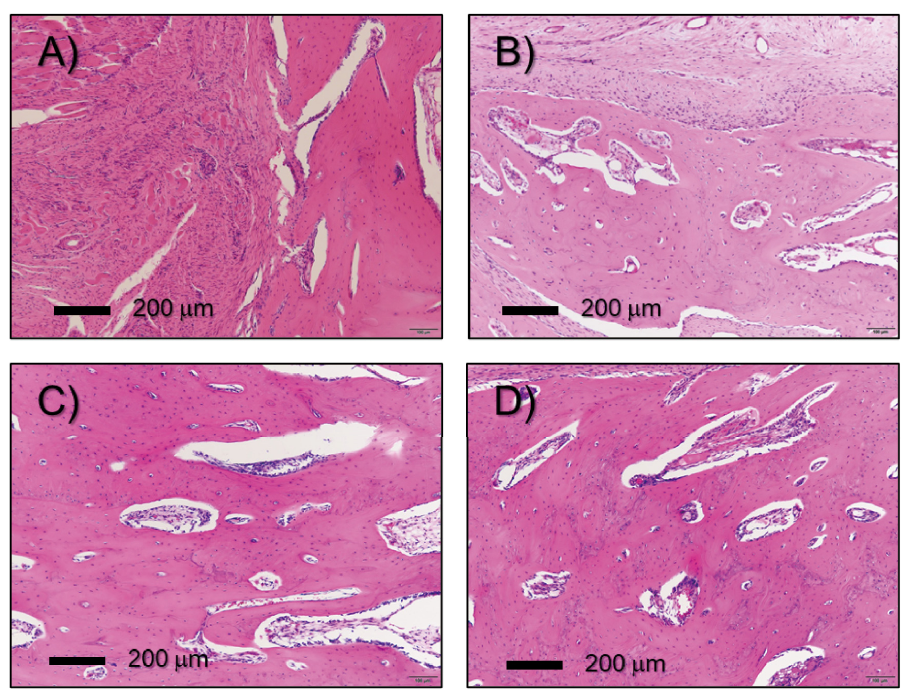
Fig 4. Histological sections were stained with hematoxylin and eosin (H&E) as a function of plasma treatment time: 4A for 0 min, 4B for 5 min, 4C for 10 min, and 4D for 15 min, respectively. Figures include a 200 μ m scale